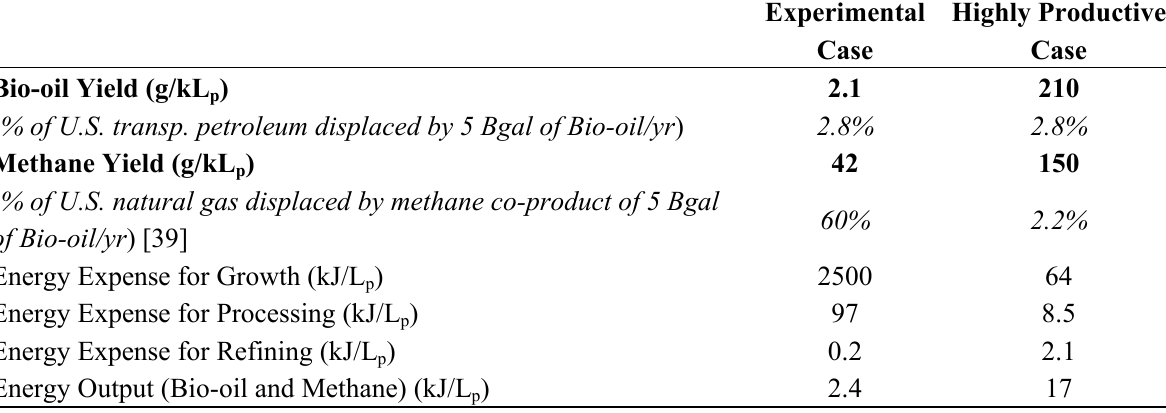
Table 3. Summary of energy, water, cost, and resource requirement results for the Experimental Case and the Highly Productive Case . The methane-to-bio-oil ratio is much greater for the Experimental Case than the Highly Productive Case due to the difference